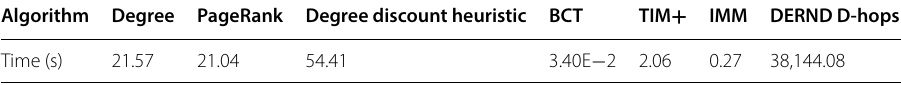
50 under the LT model =